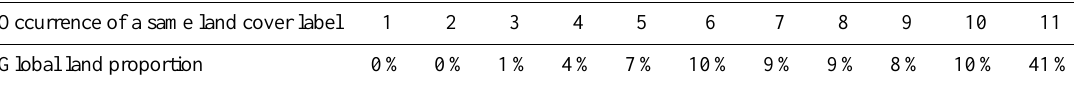
Table 4. Percentages of the world indicating the occurrence of a same land cover label in the 11 yearly global land cover products obtained by the GlobCover processing chain from the SPOT-Vegetation archive (figures obtained without considering the water class). Occurrence of a same land cover label